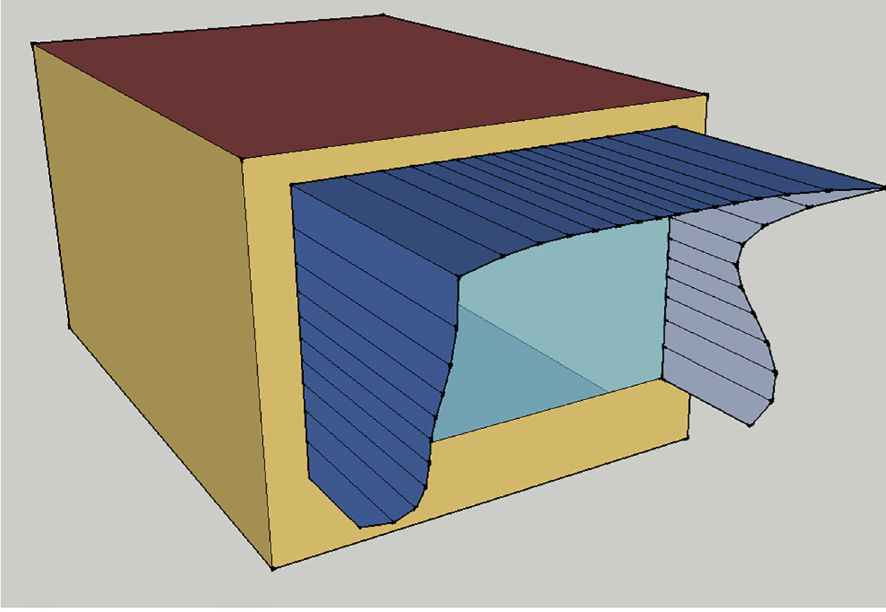
Fig 5. A better performing shading without a western hole in Miami with positions of control points (3, 7, 6, 8, 8, 7, 7, 7, 7, 7, 8, 3, 2, 6, 4).